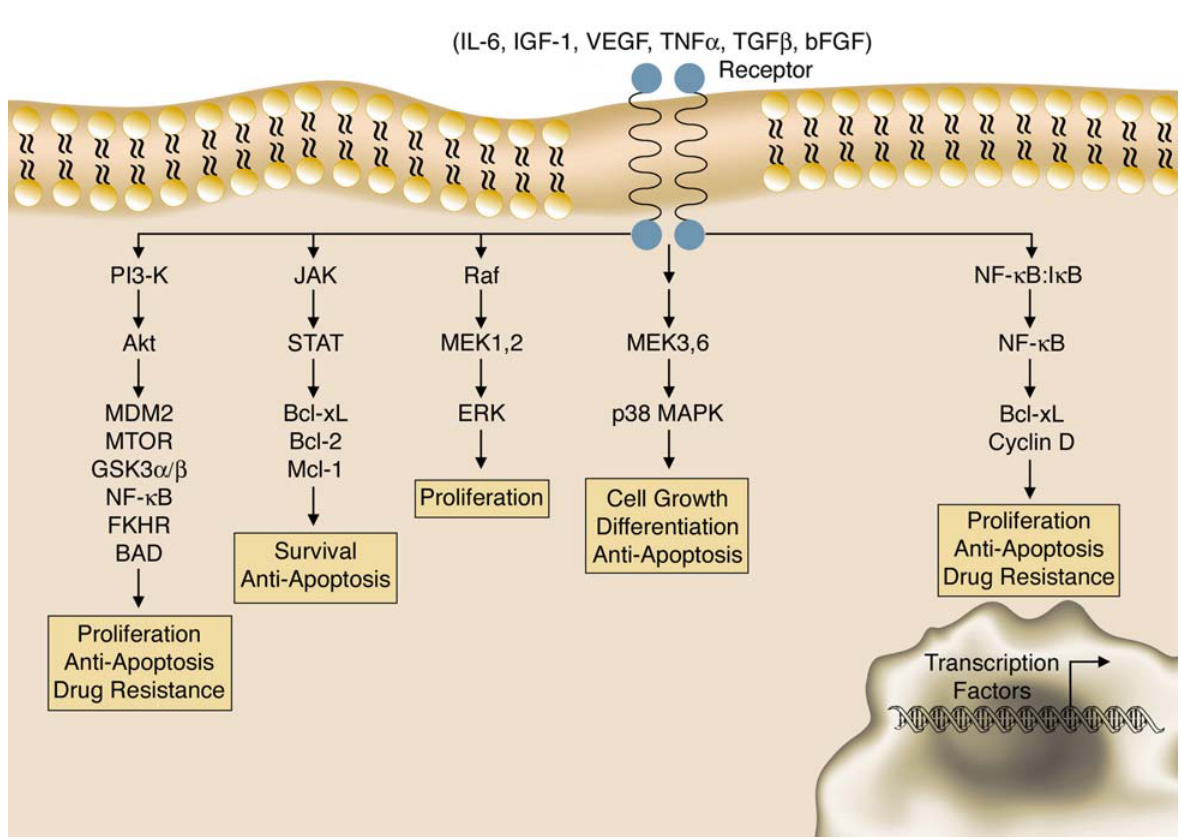
FIGURE 1 . Simplified overview of intracellular signaling